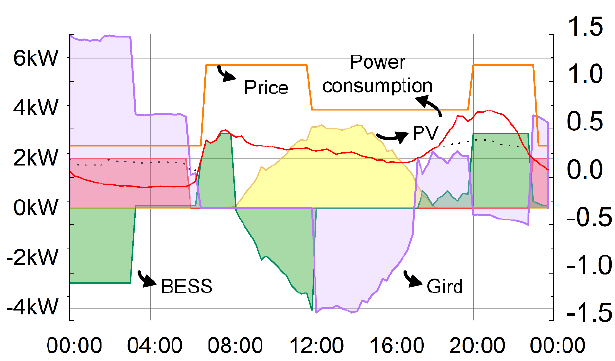
Figure 7. Electricity consumption scheduling of consumer I.